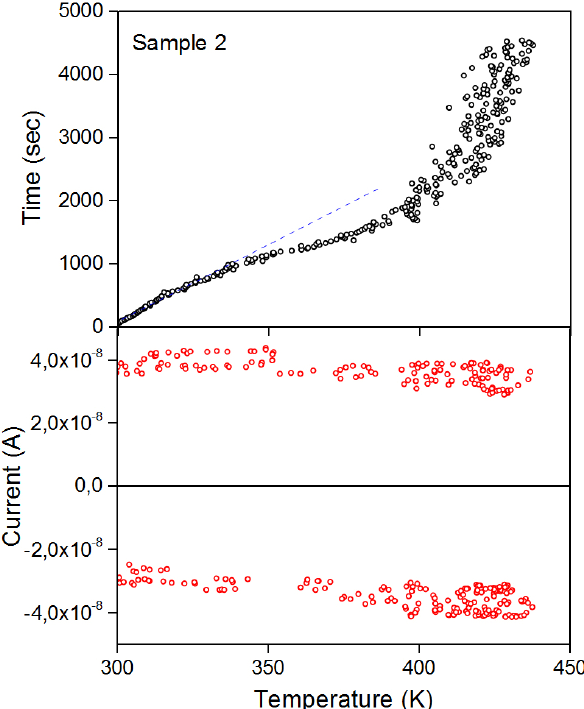
Figure 11. Pyroelectric current sample 2 BFO/Polyimide. The top graph shows the change in current over time.